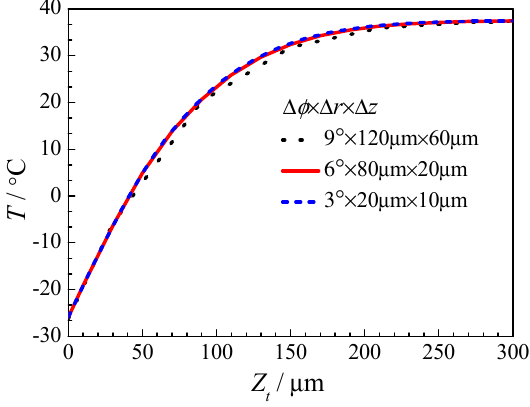
Figure 5. Axial temperature in skin tissue at different grid sizes.